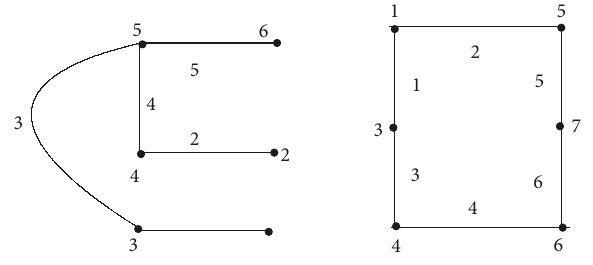
Figure 4: A classical mean labeling of G